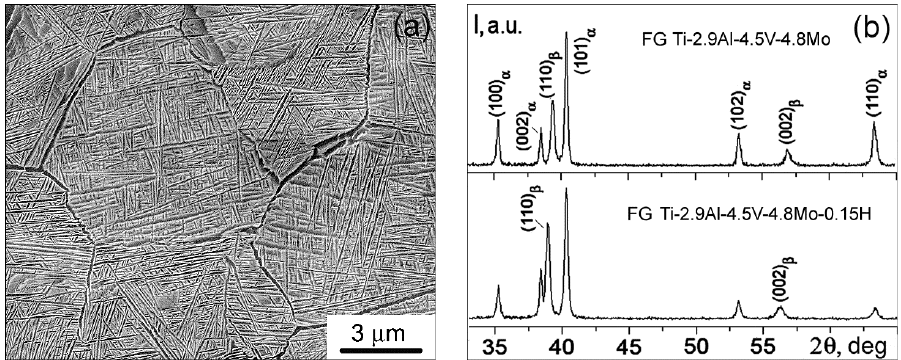
Figure 1. Microstructure ( a ) and diffraction patterns ( b ) of the FG titanium alloys.